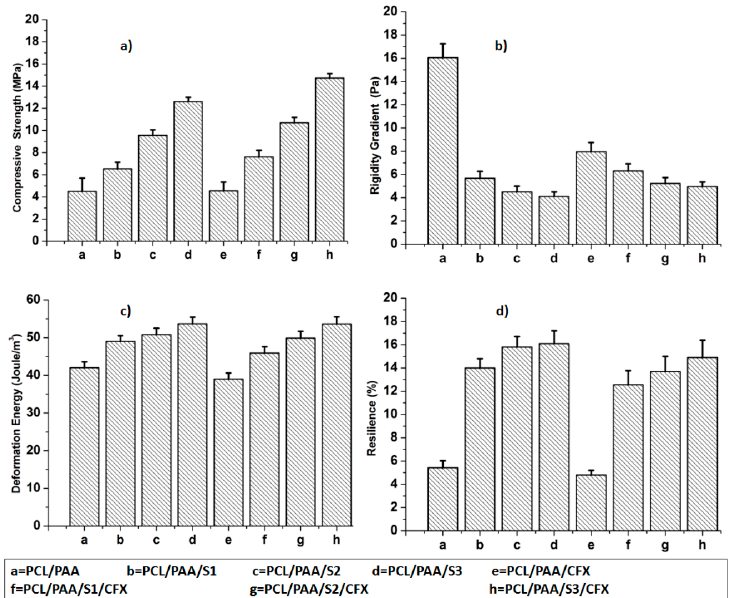
Figure 4. Physicomechanical properties of the prepared scaffolds represented by ( a ) Compressive Strength; ( b ) Rigidity Gradient; ( c ) Deformation Energy and; ( d ) Matrix Resilience (%).